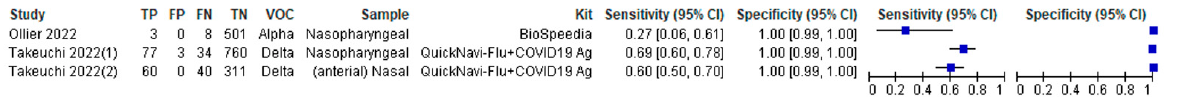
Figure 6. Coupled forest plot of sensitivity and specificity: symptomatic patients. TP, true positive; FP, false positive; FN, false, negative; TN, true negative, VOC, variants of concern.